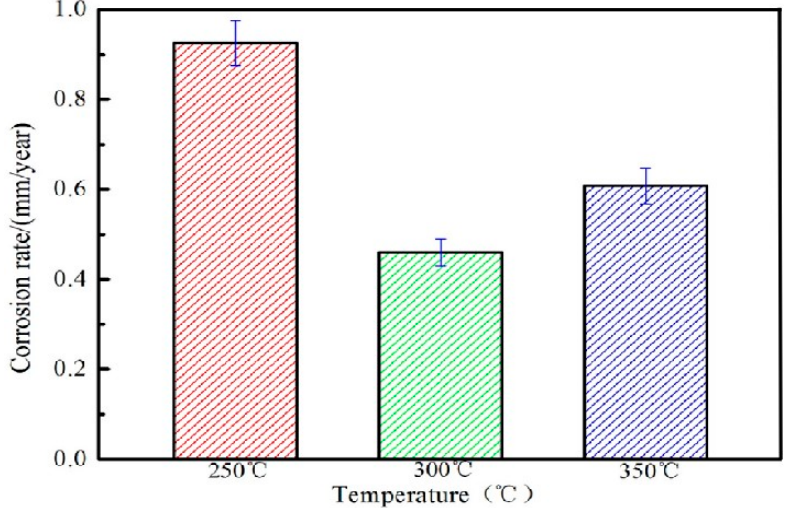
ff erent extrusion